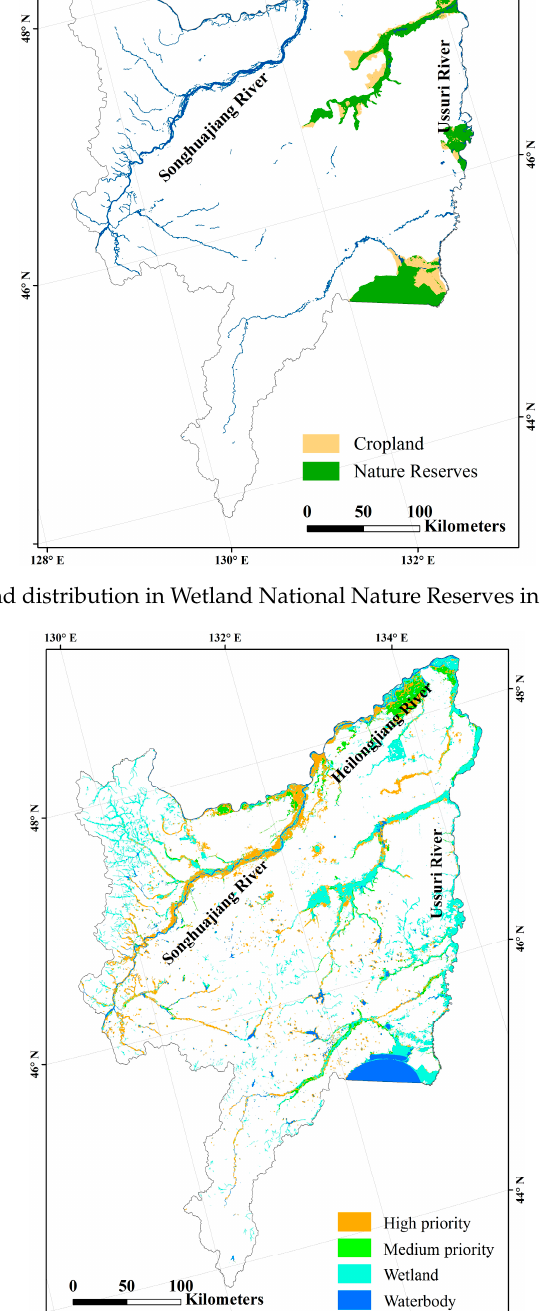
Figure 7. Spatial pattern of potential areas for wetland rehabilitation from croplands in the SJP.